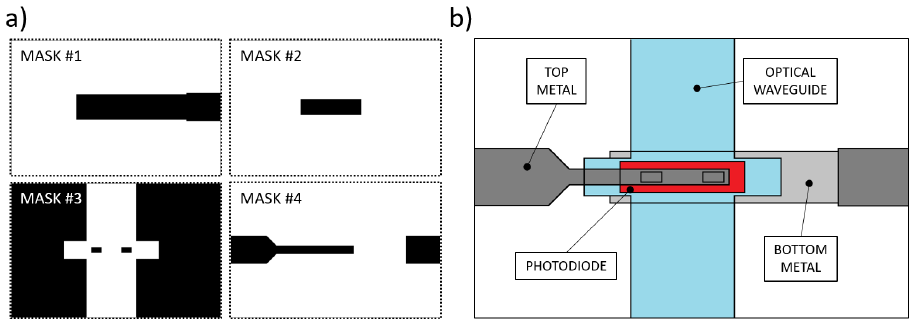
Figure 4. ( a ) Photolithographic masks used for the prototype fabrication. Mask #1: aluminum bottom contact. Mask #2: n-i-p junction patterning. Mask#3: SU-8 insulation layer and optical waveguide. Mask #4: Ti-W top metal. ( b ) Depicted top view of the fabrication result.